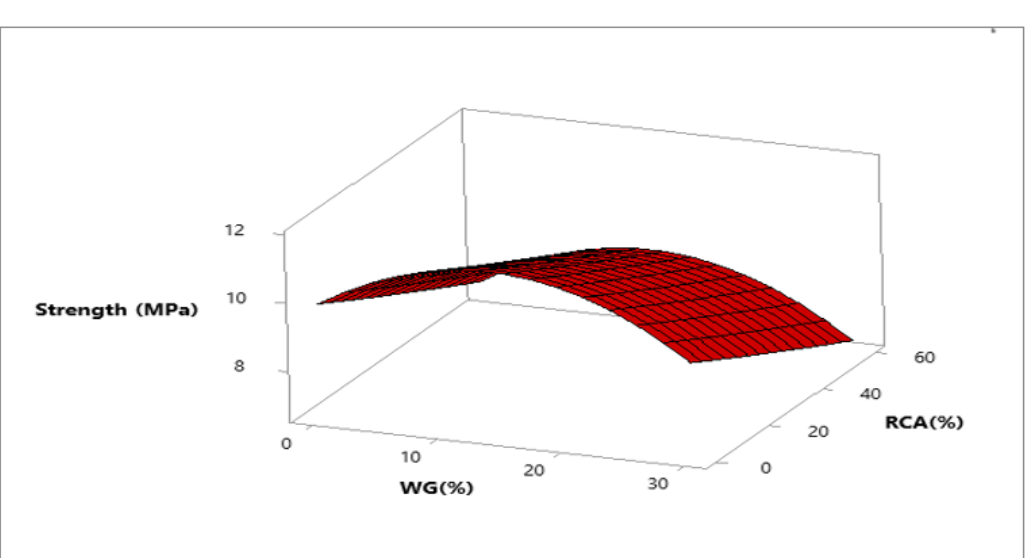
Figure 18. Three-dimensional response surface of punching strength.